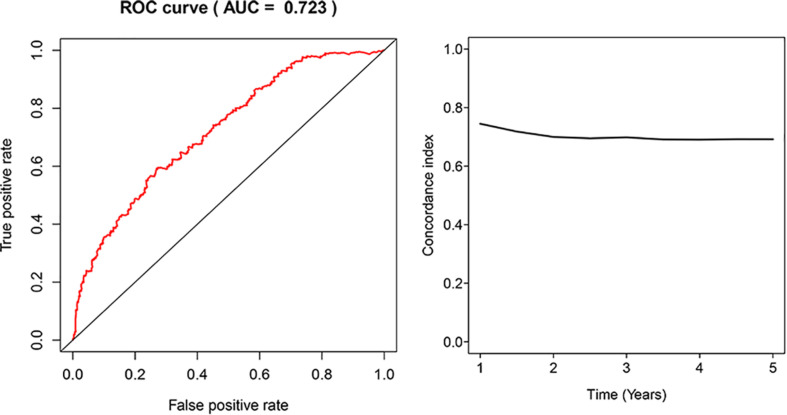
Receiver operating characteristic (ROC) analysis of the sensitivity and specificity of the risk score model and concordance index in a time-dependent Area Under the Curve (AUC) analysis.